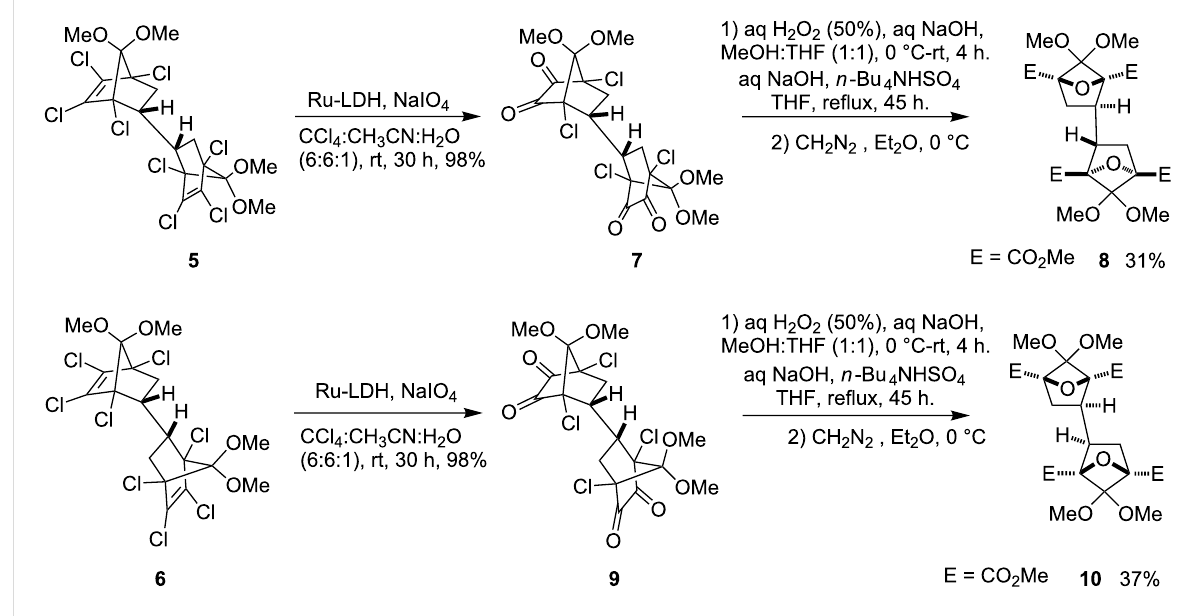
Scheme 3: Synthesis of bis-oxa-bridged compounds 8 and 10 from bis-adducts 5 and 6 .